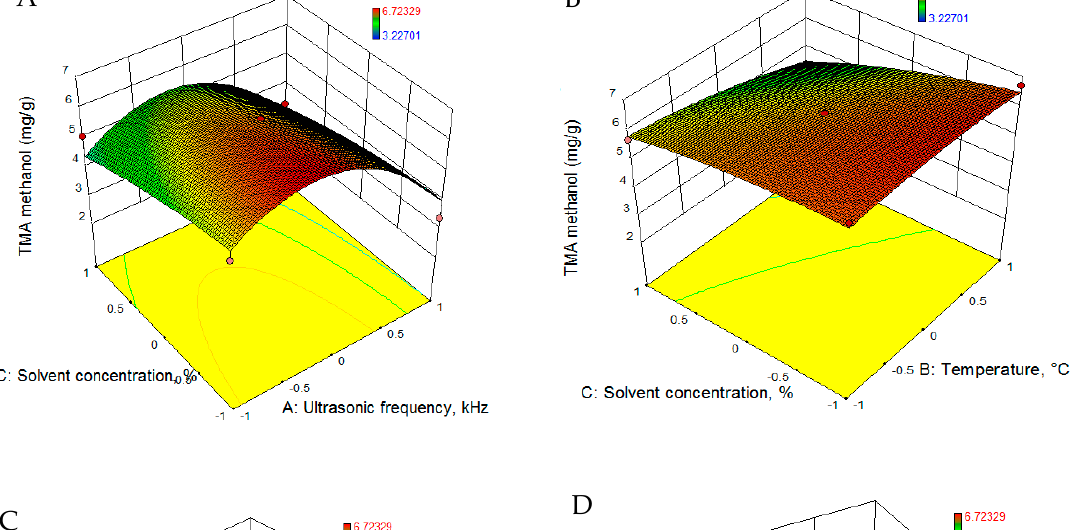
Figure 1. RSM graphs of TMA extraction evolution using 2-propanol as solvent. RSM: Response Surface Methodology, TMA: total monomeric anthocyanin.